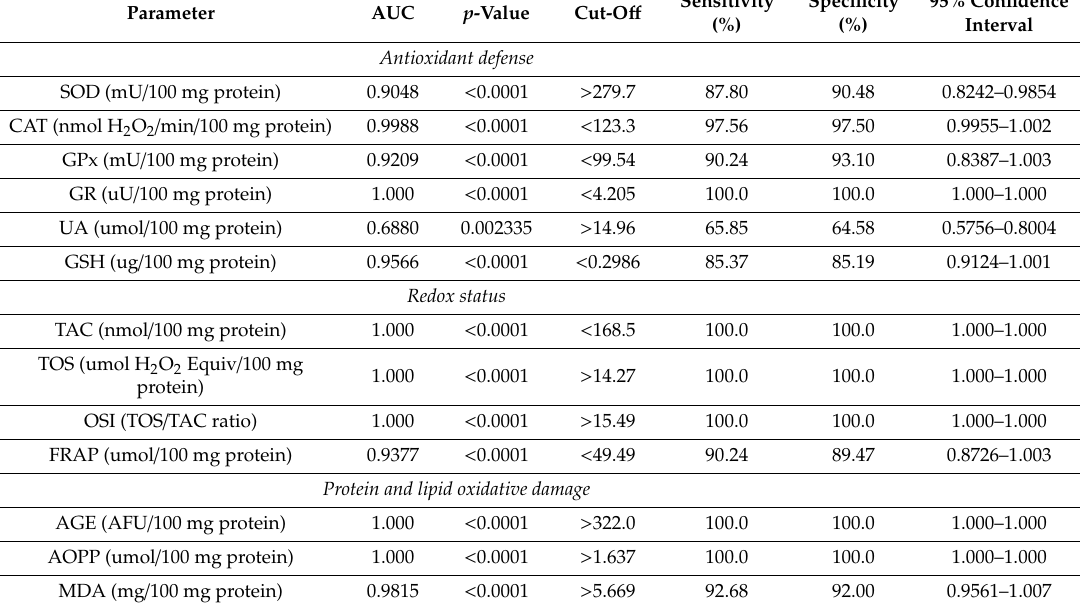
Table 2. Receiver operating characteristic (ROC) analysis of oxidative stress biomarkers of colorectal cancer patients and the controls. Abbreviations: SOD, superoxide dismutase-1; CAT, catalase; GPx, glutathione peroxidase; GR, glutathione reductase; UA, uric acid; GSH, reduced glutathione; TAC, total antioxidant capacity; TOS, total oxidant status; OSI, oxidative stress index; FRAP, ferric reducing ability of sample; AGE, advanced glycation end products; AOPP, advanced oxidation protein products; MDA, malondialdehyde.